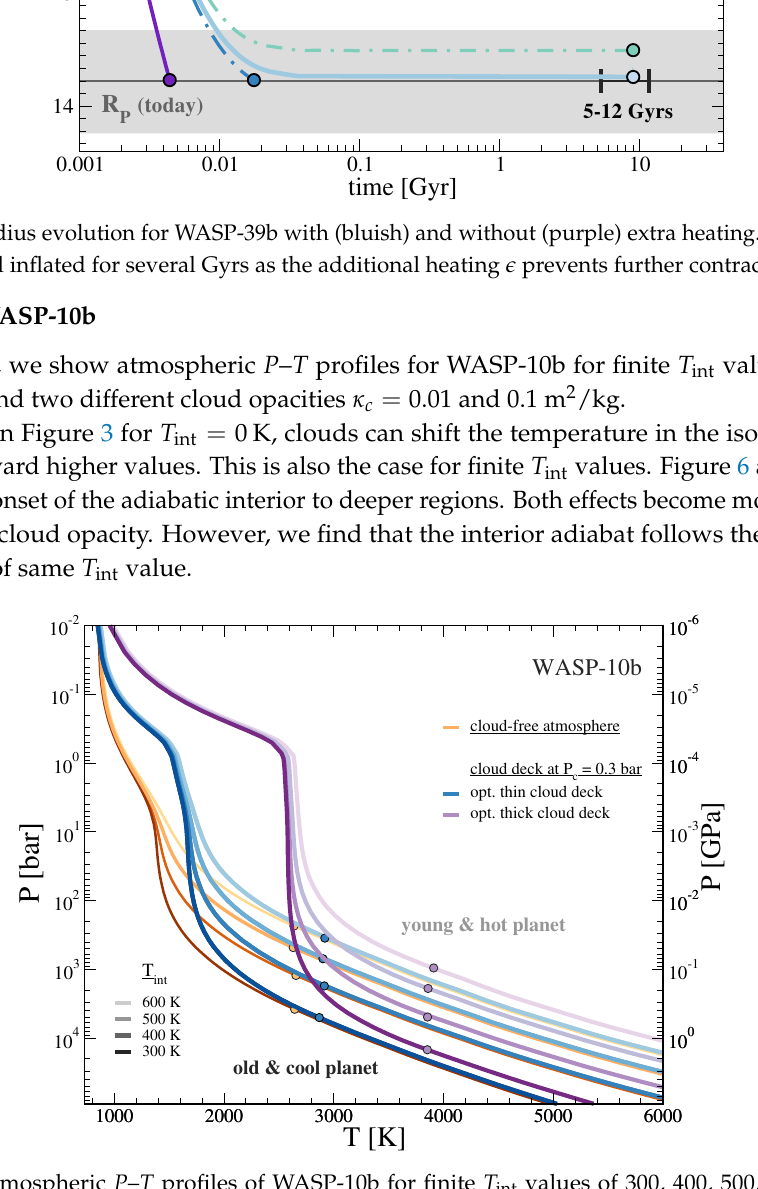
Figure 6. Atmospheric P – T profiles of WASP-10b for finite T int values of 300, 400, 500, and 600 K (from bottom to top) and three cloud deck scenarios: optically thin at 0.3 bar (blue), optically thick at 0.3 bar (purple), and cloud-free (orange). Circles mark the transition between atmosphere and adiabatic